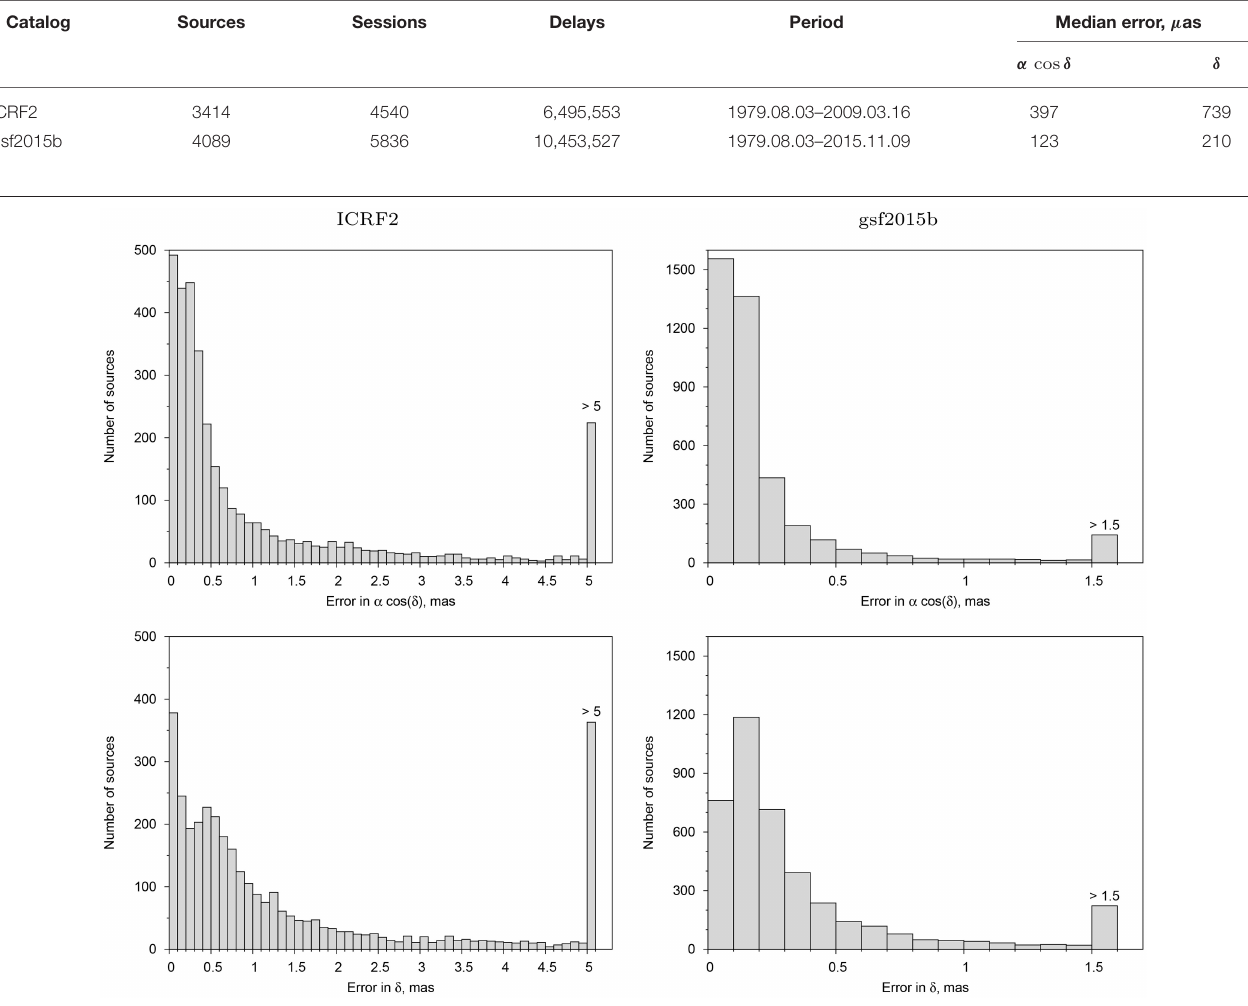
FIGURE 1 | Distribution of the source position errors in ICRF2 (left) and gsf2015b (right)